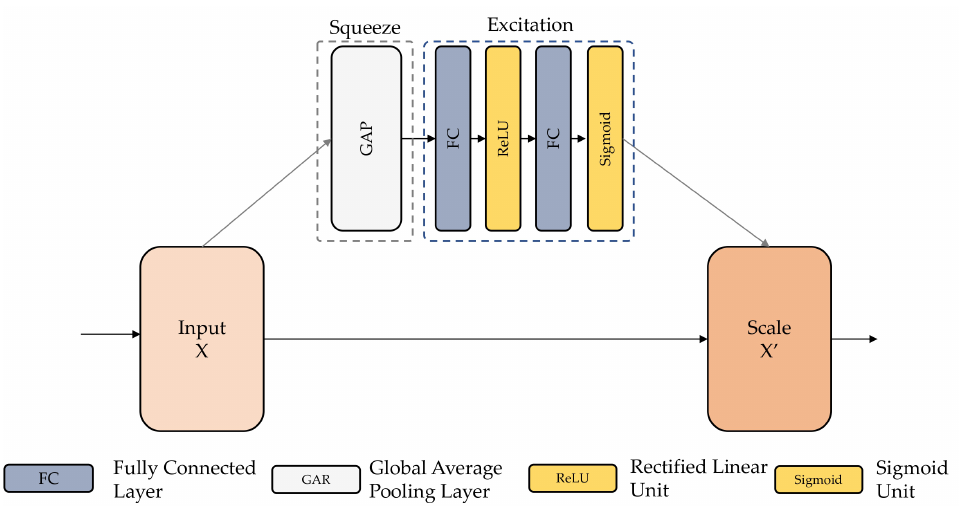
Figure 4. Structure and functionality of the squeeze-and-excitation